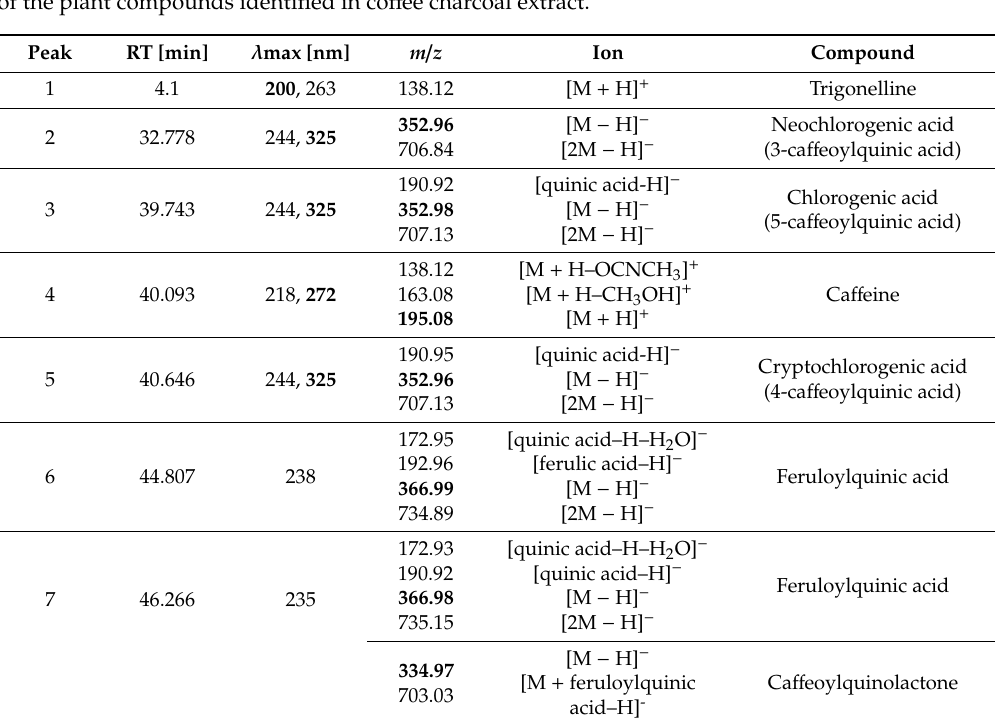
Figure 1. HPLC chromatogram of co ff ee charcoal extract with chemical structures of identified substances. Table 1. Summary of the chromatographic, UV-Vis spectroscopic and mass spectrometric characteristics of the plant compounds identified in co ff ee charcoal